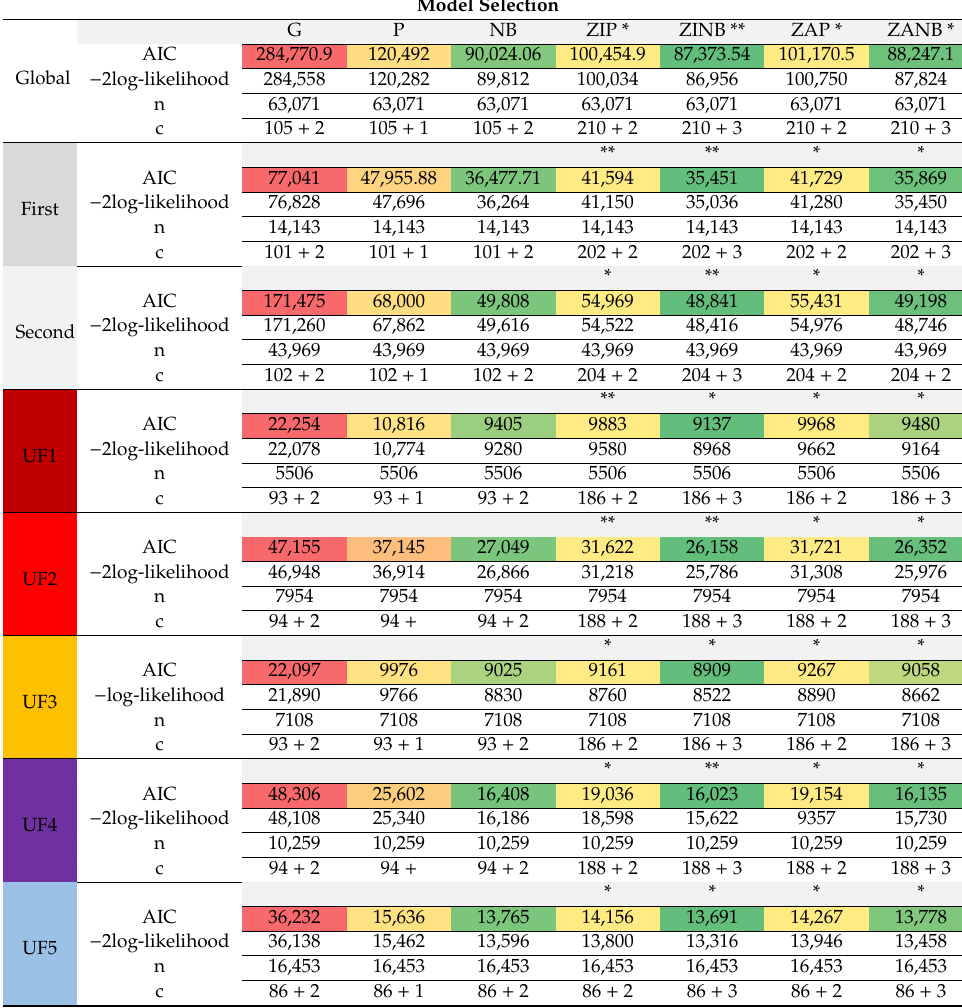
Table 2. Model selection for the overall study area and each morphological region. Model